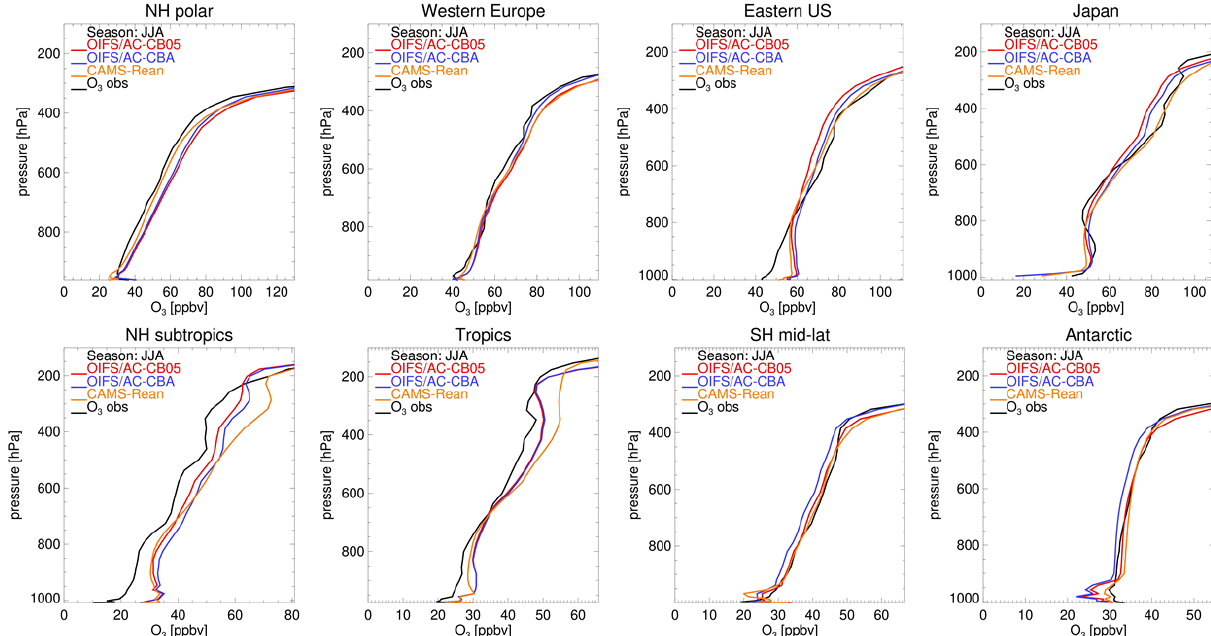
Figure 2. Evaluation of OpenIFS/AC tropospheric O 3 profiles against sondes during June, July, and August (JJA) 2010. For reference, data from the CAMS reanalysis are also provided